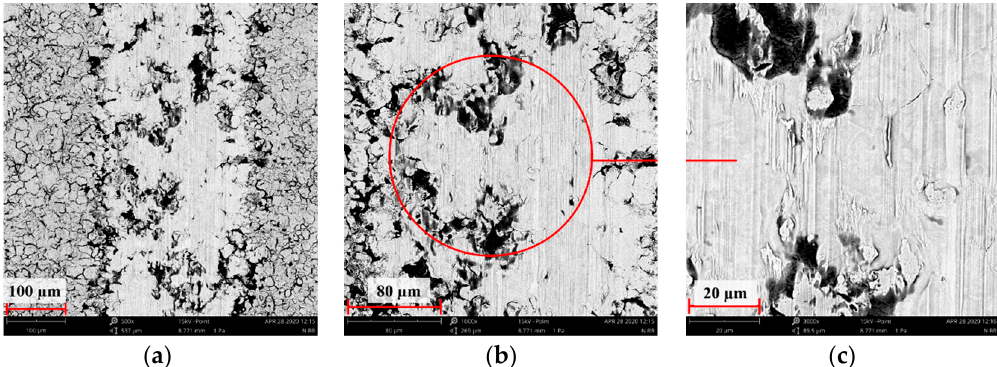
Figure 24. SEM image of the nitrogen ion-implanted steel 316L wear track after friction with RS lubrication: ( a ) ×500, ( b ) ×1000, ( c ) ×3000.